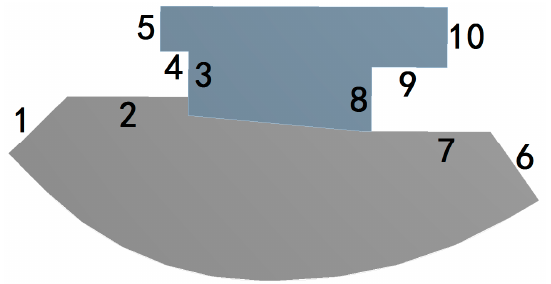
Figure 3. Two possible passageways that may lead to flame leak: ( a ) 1 → 2 → 3 → 4 → 5 and Figure 3. ( b ) 6 → 7 → 8 → 9 → 10. Table 5. The defined initial gap sizes for the chosen possible passageway. Table 5. The defined initial gap sizes for the chosen possible passageway. Fitting Surface Fitting